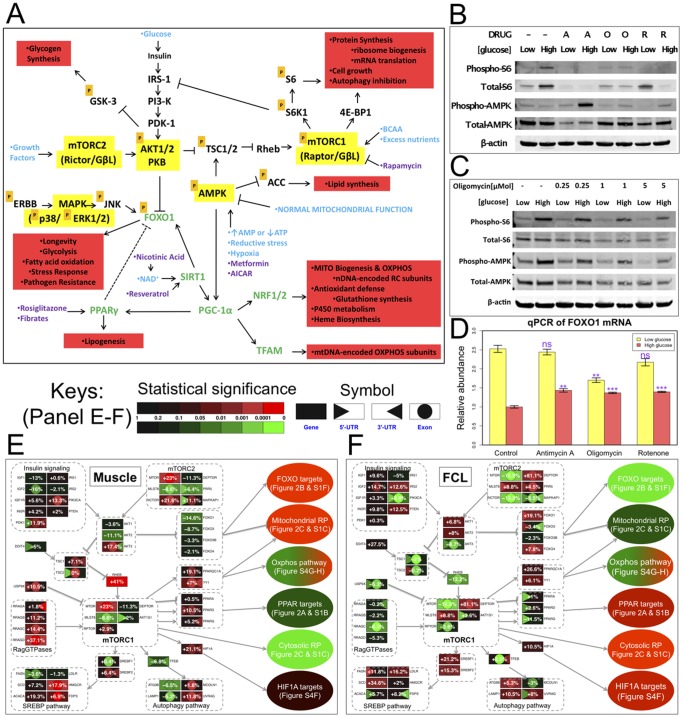
Primary RC dysfunction transcriptionally and post-transcriptionally dysregulates the integrated nutrient-sensing signaling network.(A) Integrated overview modeling general interactions between central nutrient-sensing signaling pathways. Arrows and bars convey activating and inhibiting effects, respectively. TFs, physiologic signals, and drugs known to modulate this pathway are indicated in green, blue, and purple font, respectively. “P” indicates pathway components whose activity is modulated by phosphorylation. Red boxes detail physiologic effects. (B) Oligomycin-based pharmacologic RC inhibition in human FCLs alters mTORC1 and AMPK pathway activities. To confirm primary mitochondrial RC dysfunction was sufficient to alter mTORC1 signaling, FCLs from a healthy individual were treated in DMEM medium containing 20% fetal bovine serum for 24 hours and either low (1 g/L or 5 mMol) or high (4.5 g/L or 25 mMol) glucose, with either the complex V inhibitor, Oligomycin, (“O”, 5 uMol), an AMPK activator, AICAR (“A”, 2 mMol), or the mTORC1 inhibitor, rapamycin (“R”, 100 nMol). Regardless of glucose concentration, expression of a standard readout of mTORC1 pathway activity, phospho-S6 protein level, was reduced by oligomycin treatment, while increased phospho-AMPK expression was evident in high glucose media. (C) Oligomycin-based alteration of mTORC1 and AMPK pathway activities is dose- and nutrient-dependent. The same control FCLs as in (B) were treated for 24 hours in either low (1 g/L or 5 mMol) or high (4.5 g/L or 25 mMol) glucose media with oligomycin in doses ranging from 0.25 uMol to 5 uMol. A general trend is evident of overall reduced phospho-S6 and phospho-AMPK at increasing doses of oligomycin. See also Fig. S13 in File S3. (D) Pharmacologic RC inhibition increases
FOXO1
 expression in high-glucose conditions. FCLs were treated for 24 hours in either low (1 g/L or 5 mMol) or high (4.5 g/L or 25 mMol) glucose media with a RC inhibitor targeting either complex I (rotenone, 0.1 uMol), III (antimycin A, 0.5 uMol), or V (oligomycin, 1 uMol). As expected, FOXO1 expression was inhibited by high-glucose media. All three RC inhibitors increased FOXO1 relative expression in high-glucose conditions, whereas FOXO1 expression was decreased by oligomycin in low-glucose media. (E–F) Integrated view of detailed gene and sub-gene level transcriptional alterations in RC disease among central nutrient-sensing signaling network modulators. Their major downstream targets and pathways were presented in separated plots. An overall inverse expression pattern is evident in RC disease between (E) skeletal muscle and (F) FCL.